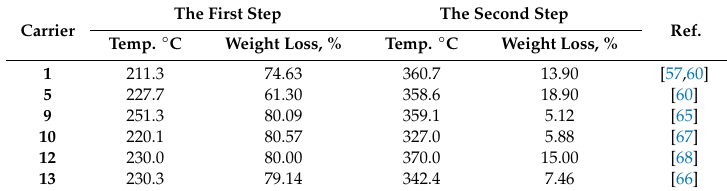
Table 15. Degradation temperatures and weight losses of CTA- o -NPPE membranes with alkylimidazoles.